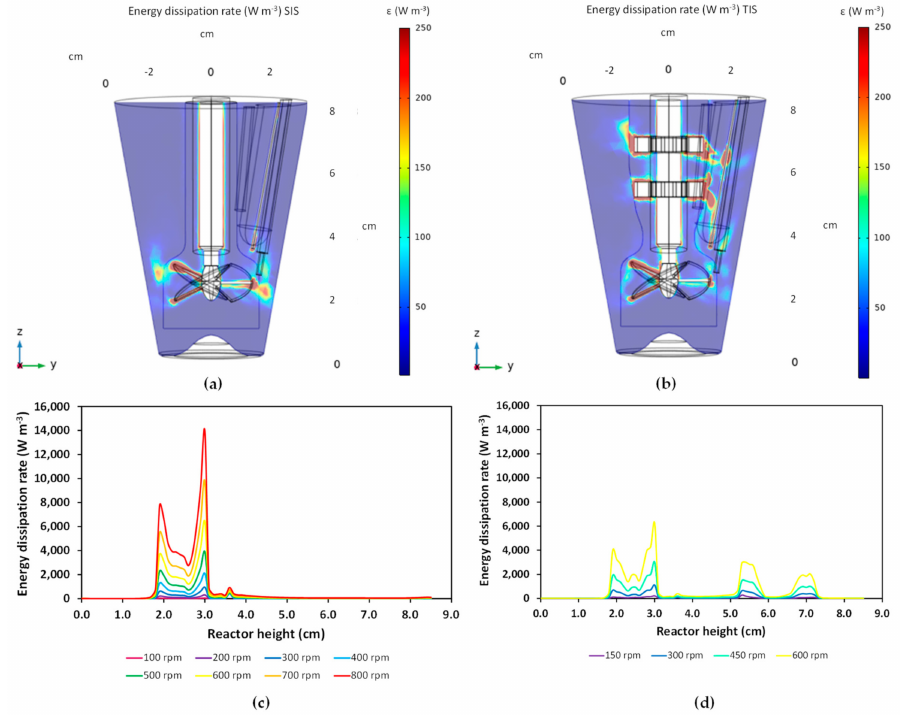
Figure 2. Energy dissipation rate ε in the SIS and TIS: ( a ) energy dissipation rate in the SIS; ( b ) energy dissipation rate in the TIS. The shown data correspond to an agitation rate of 400 rpm. ( d ) Mean energy dissipation rate along the reactor height (slice plot) in the SIS for different agitation rates; ( d ) mean energy dissipation rate along the reactor height (slice plot) in the TIS for different agitation rates. In ( c , d ), the energy dissipation rate was averaged across the diameter in steps of one millimeter along the reactor